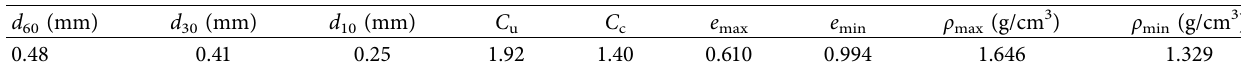
Figure 4: Experimental material properties. (a) Particle size distribution curve of standard sand. (b) Tensile strength of the triaxial geogrid in 0 ° direction. Table 1: Physical properties of standard sand.